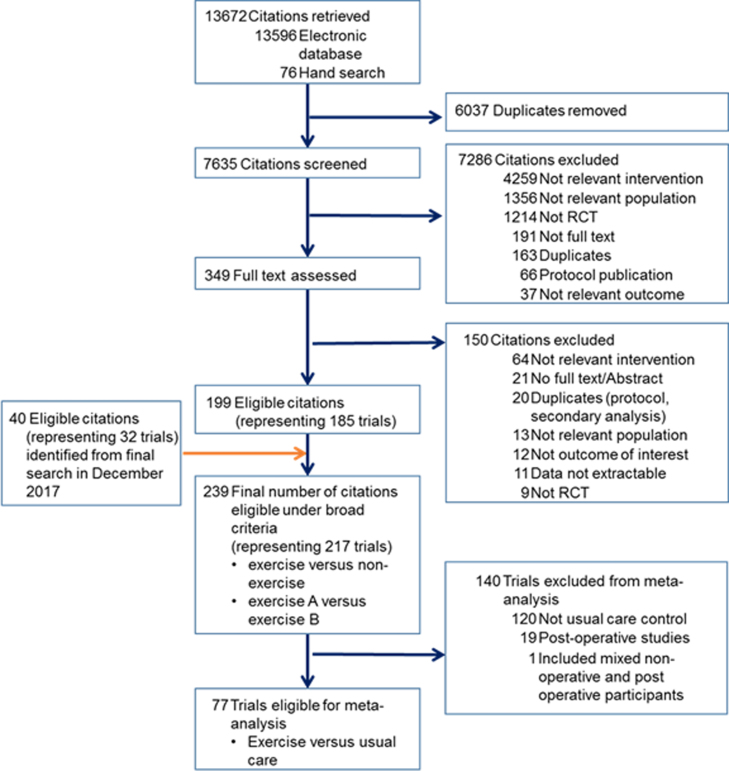
Flow diagram of study selection. RCT, randomised controlled trial.